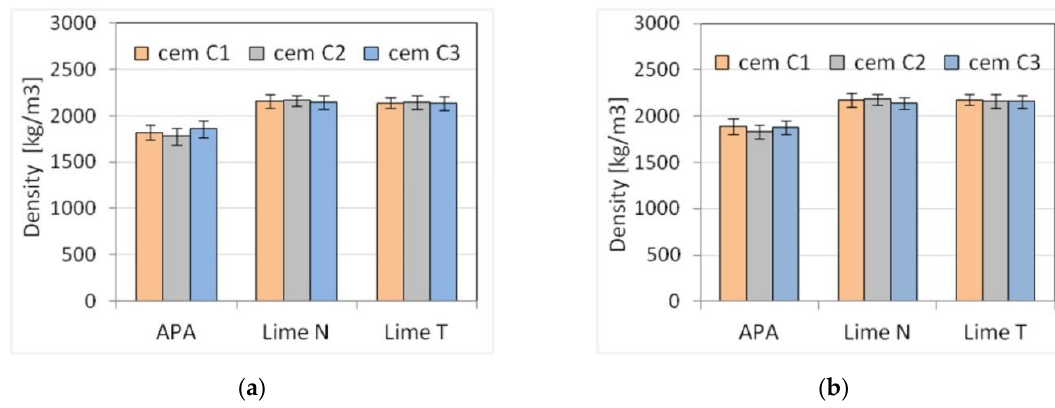
Figure 5. Influence of the cement type on the density of ( a ) plaster, ( b ) masonry mortars.